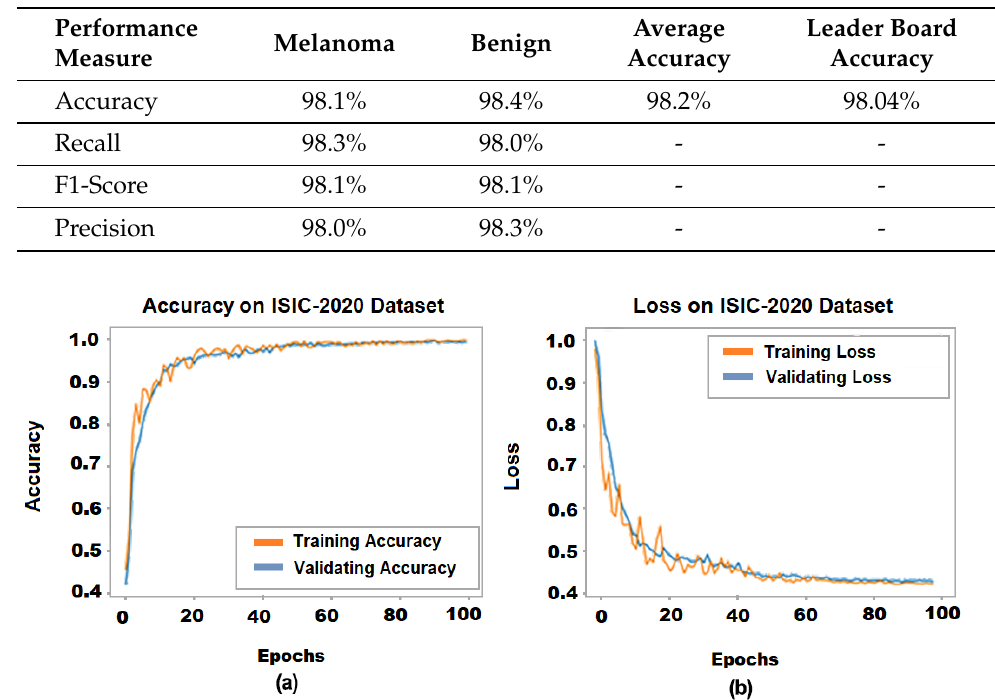
Figure 6. ( a ) Accuracies graph, and ( b ) loss graph of the proposed